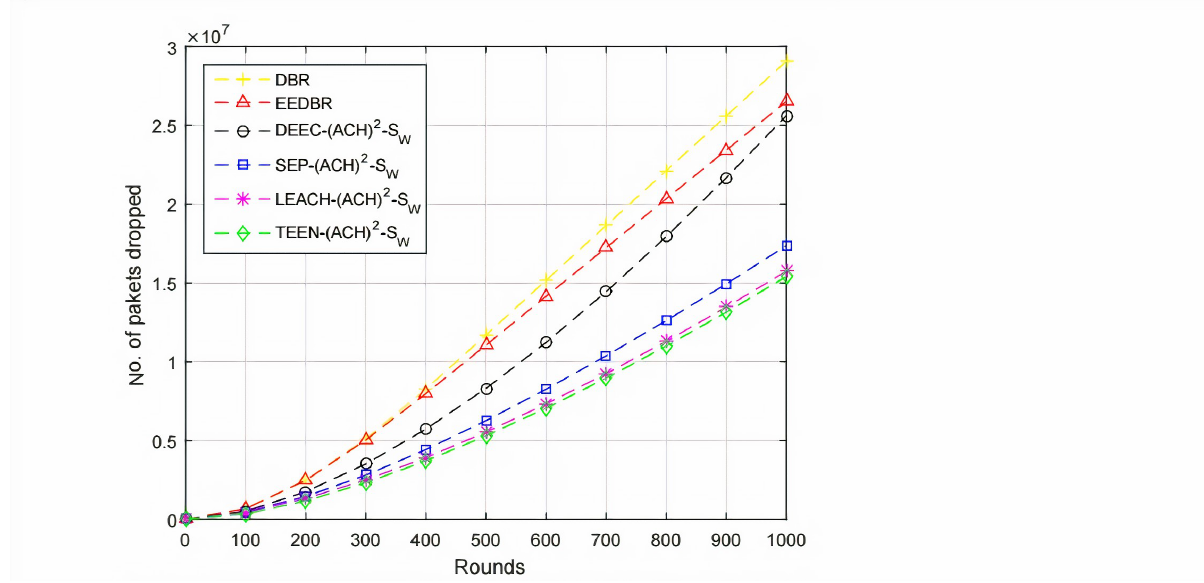
Figure 6. Number of Packets Dropped.